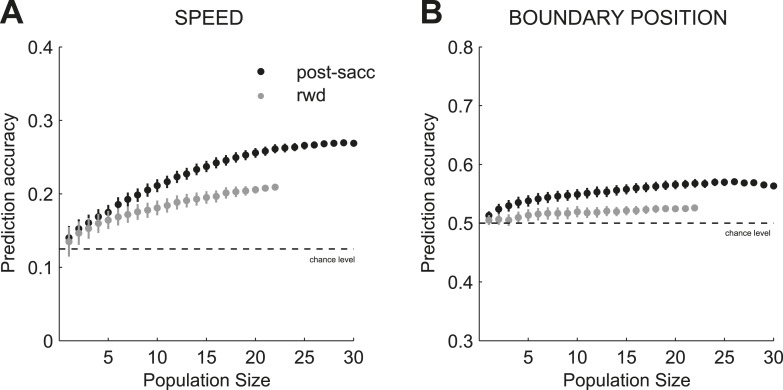
Prediction accuracy and population size.Prediction accuracy for stimulus speed (A) and boundary position (B) as a function of neuronal population size for neurons with activity during post-saccade (black) and reward (gray) periods of the task. The decoding performance plateaued faster for the boundary position (∼5 neurons) compared to the speed (∼10–15 neurons) in each neuronal population suggesting more redundant coding for the boundary position. Chance levels are shown in dashed line.